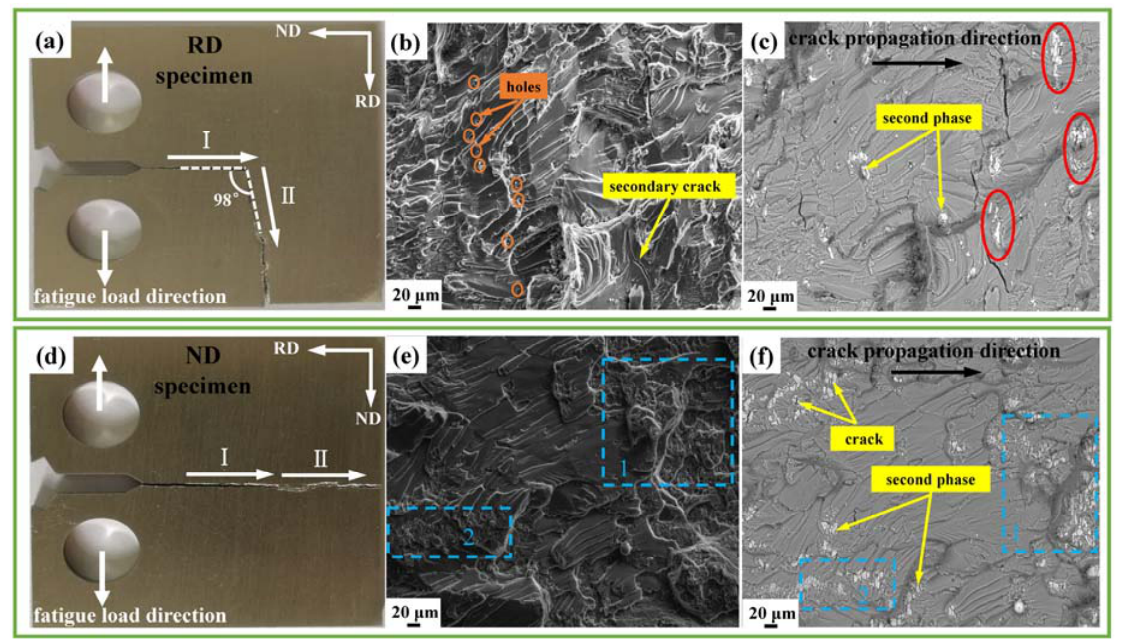
Figure 9. Macroscopic morphology and fractography of fatigue fracture surface of CT specimen: ( a , d ) macroscopic photos of specimens; ( b , e ) SEM fractography of fatigue fracture surface in steady state stage at location I; ( c , f ) the backscattered electron detector (HDBSD) images of ( b , e ).